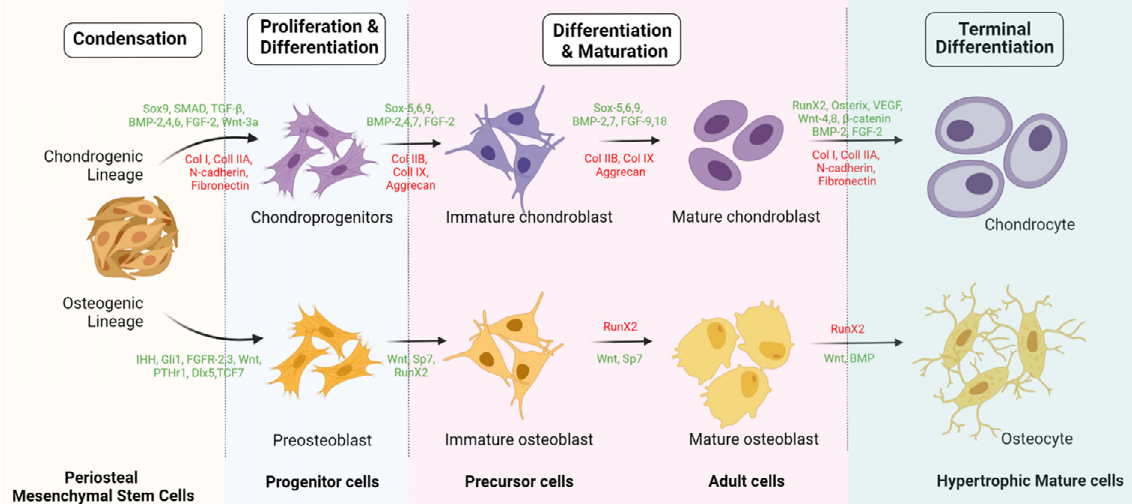
Figure 3. Intracellular signaling of osteogenic and chondrogenic differentiation of periosteal mesenchymal stem cells. Created with BioRender.com.